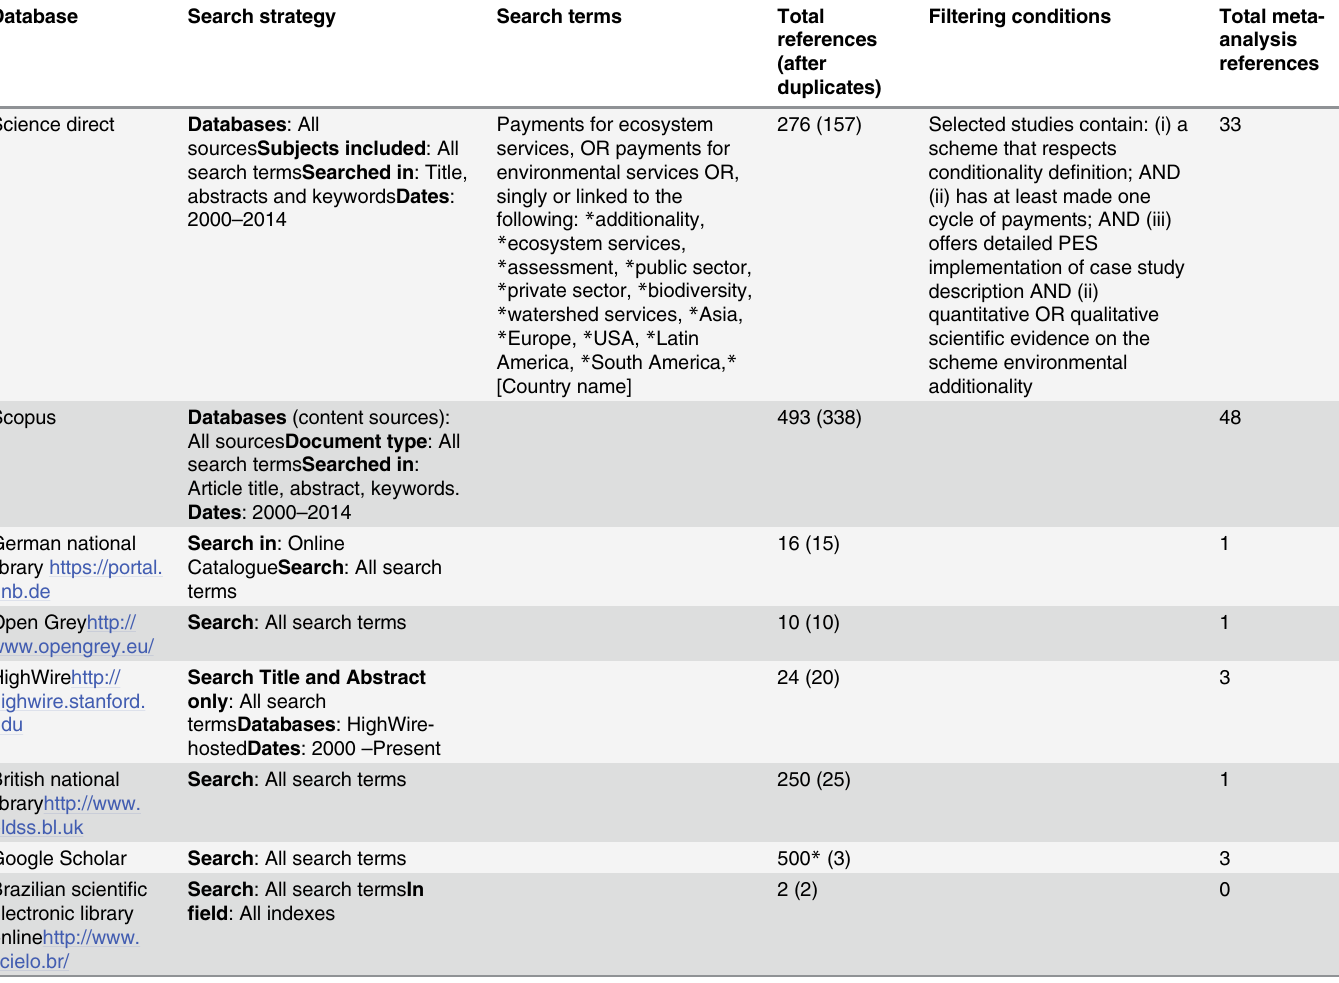
Table 1. Database search protocol for PES studies included in study